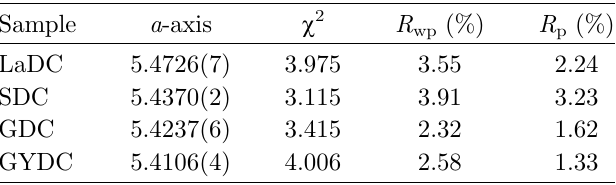
Table 2. LaDC, SDC, GDC, and GYDC lattice param- , and R values. eters, v 2 , R wp p